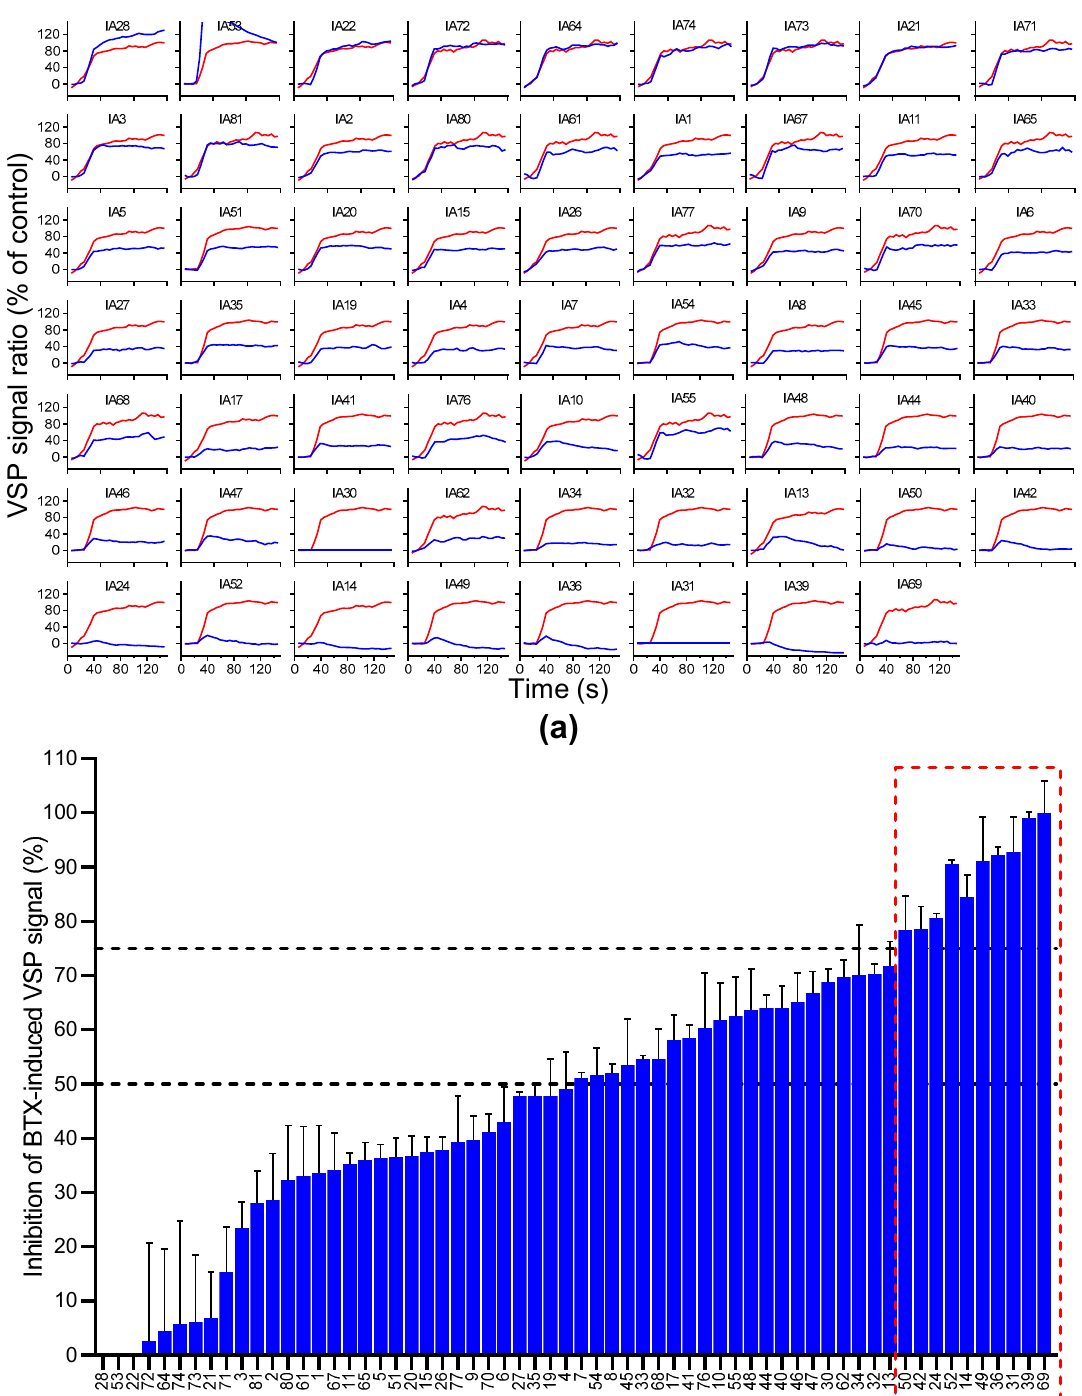
Figure 4. Screening of 62 samples from an in-house library of plant alkaloids for inhibitors of Na V channels. ( a ) Average kinetic ratios of VSP signal obtained in the presence of BTX alone (red line) and BTX co-incubated with IA (blue line), before and after injection of the depolarizing solution (at 30 s). Red and blue traces correspond to distinct experiments. x axis: fluorescence ratio (a.u.), y axis: time (s). ( b ) The histogram bars correspond to the inhibition of the BTX-induced VSP signal (in %). Ten IA induced at least 75% of the inhibition of BTX-induced depolarization (red dashed rectangle). Data are mean ± SEM ( n = 3). Table 1. Chemical analysis of IA selected for their ability to inhibit a BTX-induced VSP signal.